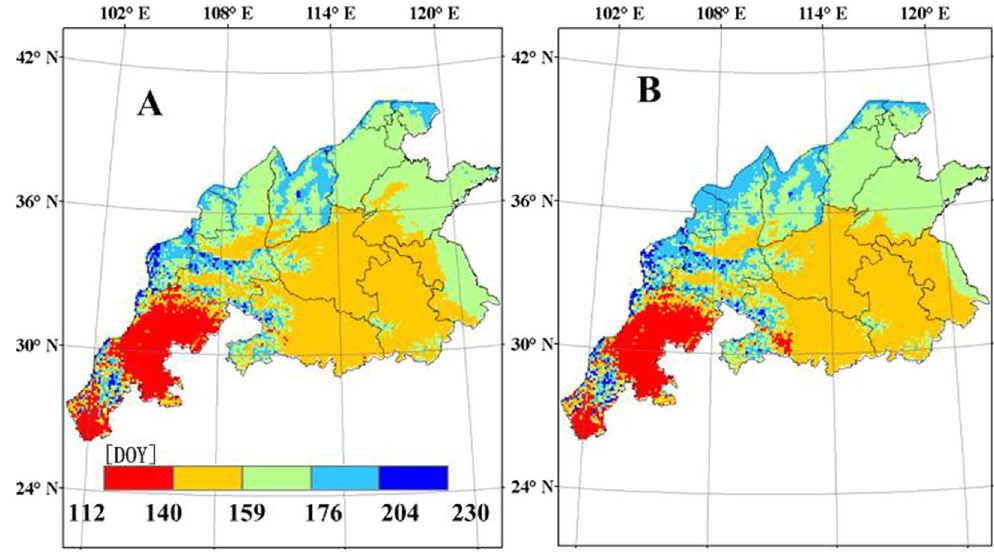
Figure 6. Spatial distribution of simulated maturity (DOY) of winter wheat in the main production regions of China from 1998 to 2008, ( A ) CERES-Wheat; ( B ) WheatGrow (This figure was created by ArcGIS 9.3, http:// www.esri.com/arcgis/).